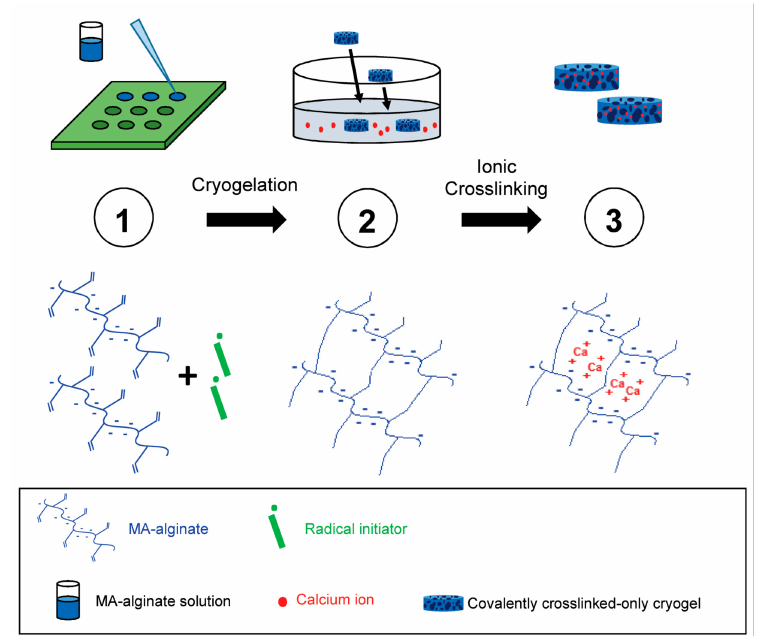
Figure 7. Schematic diagram for the production principle of MA-alginate tough cryogels